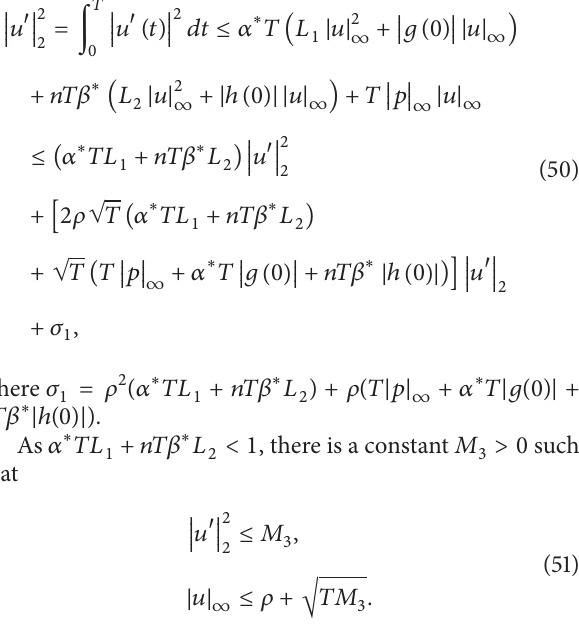
Figure 2: Time series of periodic solution of